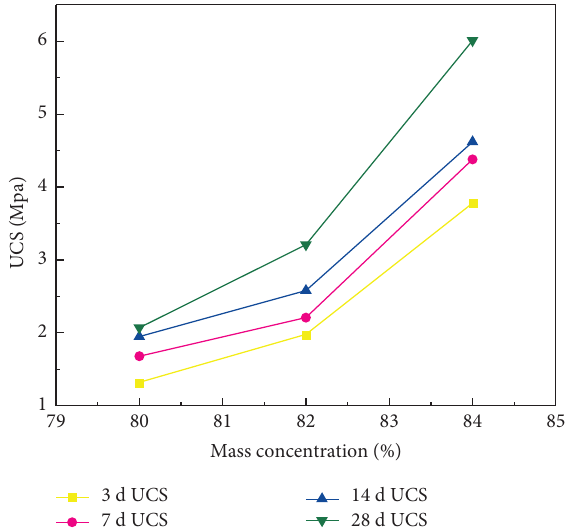
Figure 7: Te relationship between UCS and mass